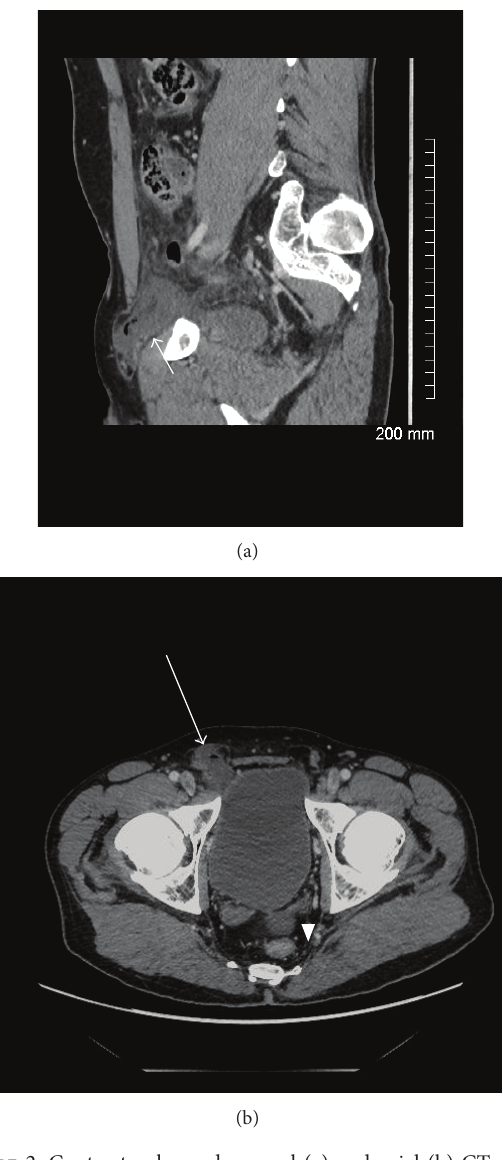
Figure 2: Contrast enhanced coronal (a) and axial (b) CT of the abdomen in a 45-year-old male with an inguinal trauma, showing right inguinal hernia, with extraluminal air (white arrow) and fluid in the peritoneal cavity